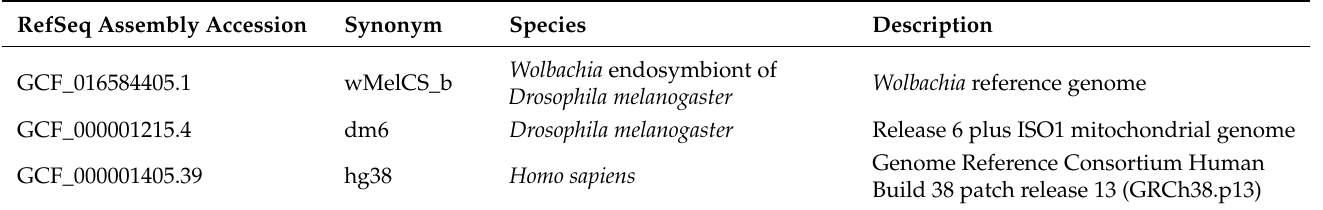
Table 1. Reference genomes against which our sequence data sets were mapped, with their Genbank accession